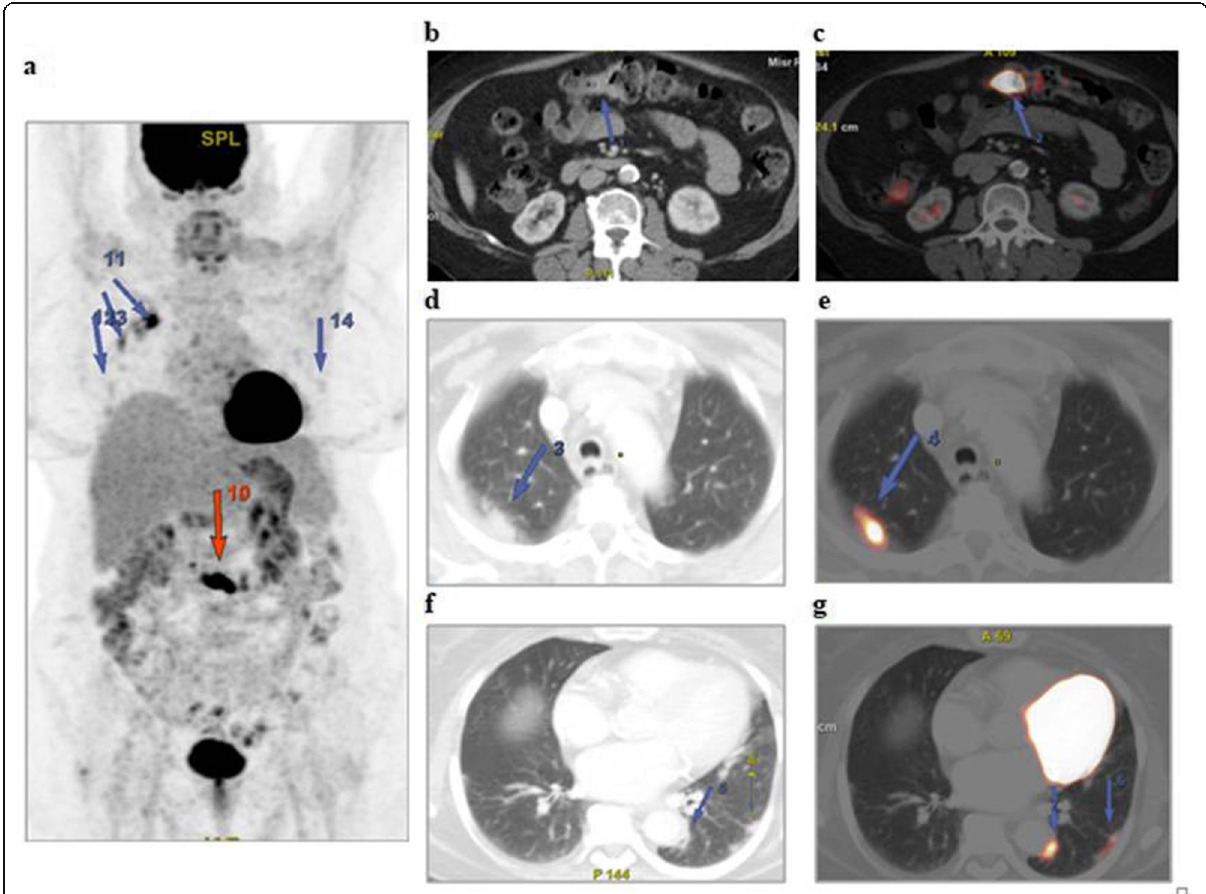
Fig. 2 A 70-year-old female patient, presented with recently diagnosed cancer colon (adenocarcinoma grade II) and referred for initial PET CT evaluation. The whole-body MIP image ( a ) shows FDG avid lesion at the mid transverse colon (red arrow) with other bilateral pulmonary active lesions of variable FDG uptake (blue arrows). Axial abdominal CT and corresponding fused PET/CT images ( b , c ) revealed a short segment of FDG avid irregular circumferential malignant soft tissue mural thickening at the mid transverse colon. Axial lung window CT images ( d , f ) revealed bilateral subpleural ground-glass opacities and consolidations that show variable FDG avidity on corresponding fused PET/CT images ( e , g ) achieving up to 6.9